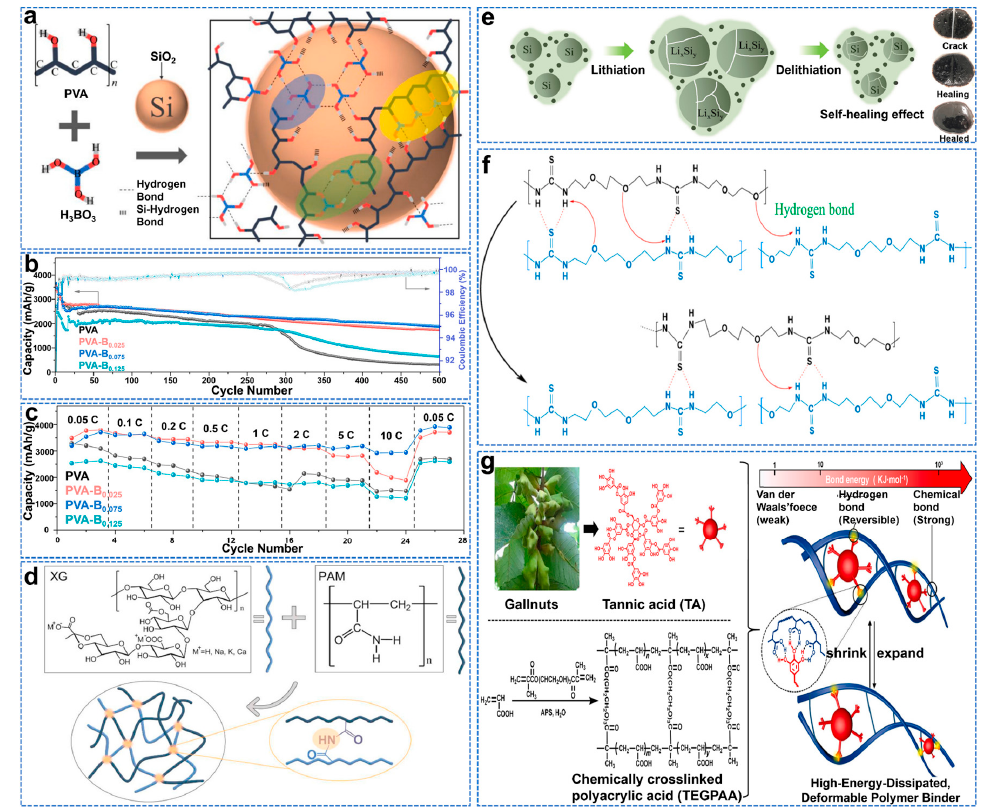
Figure 10. ( a ) Schematic of the cross − linking mechanism for PVA − B complexes and the interaction with the − OH on Si surface, ( b ) Long − term cycling performances, ( c ) Rate capability for the PVA − B binder at different BA molar fractions prepared at 40 °C for 10h [97]. ( d ) Schematic diagram of the cross − linked reaction between XG and PAM [101]. ( e ) Schematic representations of lithiation/de − lithiation of Si particles using the SHPET binder, ( f ) The self − healing mechanism: the slip motion of hydrogen bonds on SHPET backbones enables the patching function [105]. ( g ) The synthesis of highly − energy − dissipated and deformable polymer binder (TEGPAA − TA) for Si anode [106].